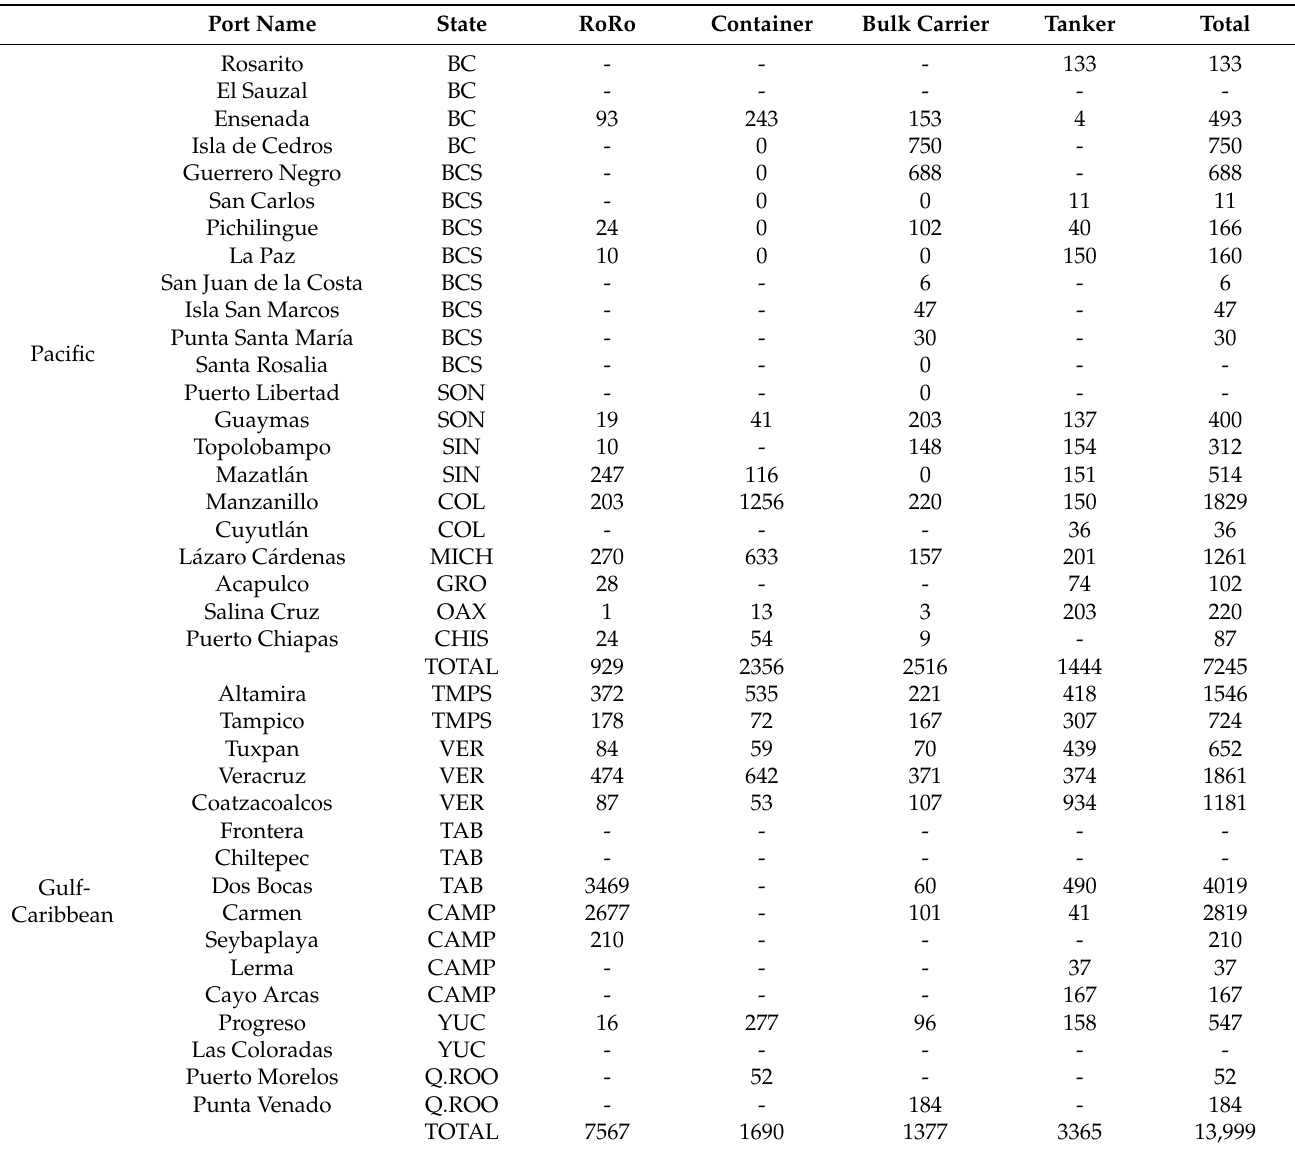
Table 1. Arrival of vessels in each port on the Pacific and Gulf-Caribbean during